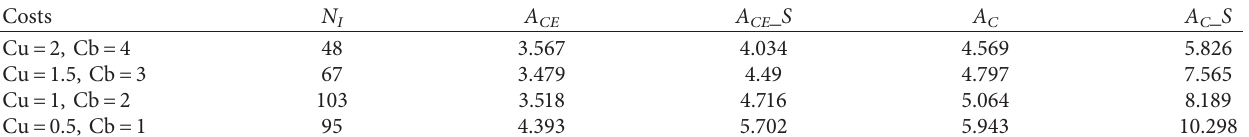
Table 2: The partial indicators of cooperative innovation network under different transformation